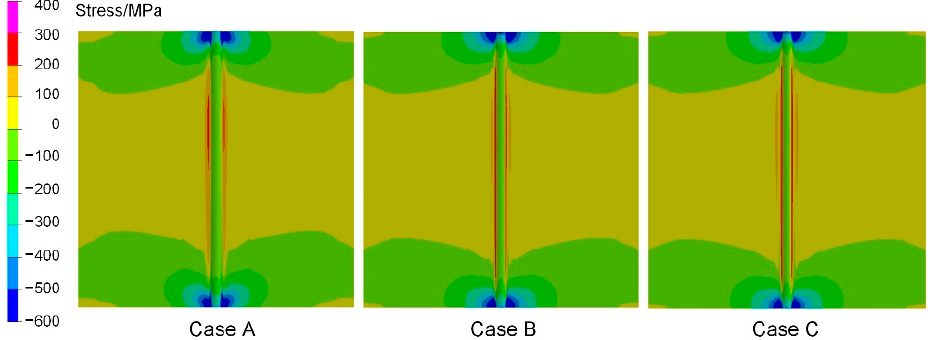
Figure 18. Transverse residual stress distribution on the upper surface of the joint.